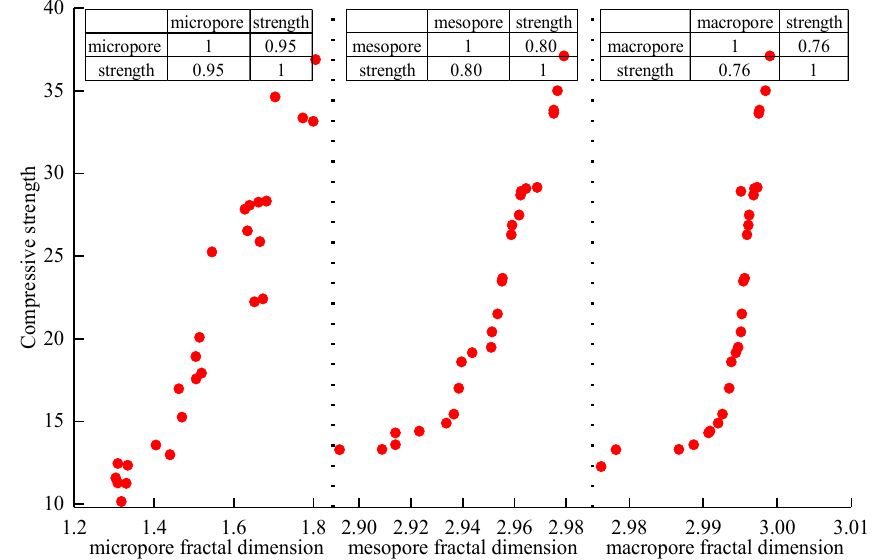
Figure 3. Law of pore size fractal dimension and compressive strength.